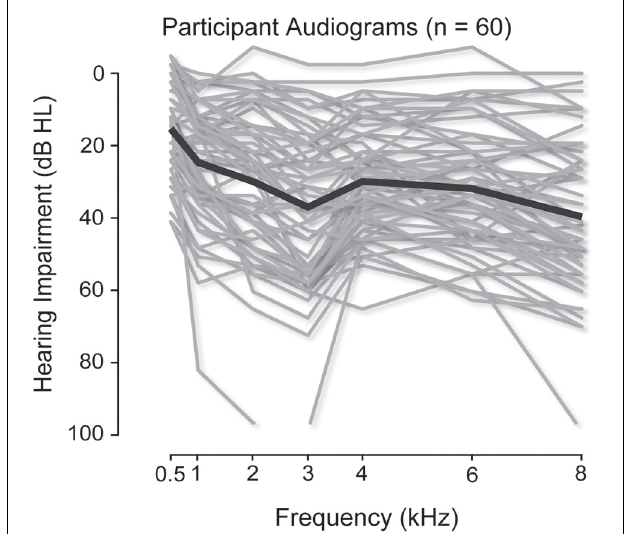
FIGURE 1 | Audiograms for the participants. The individual audiograms, measured at 500, 1000, 2000, 3000, 4000, 6000, and 8000Hz, of all listeners are plotted in gray. The mean audiograms are plotted as solid black